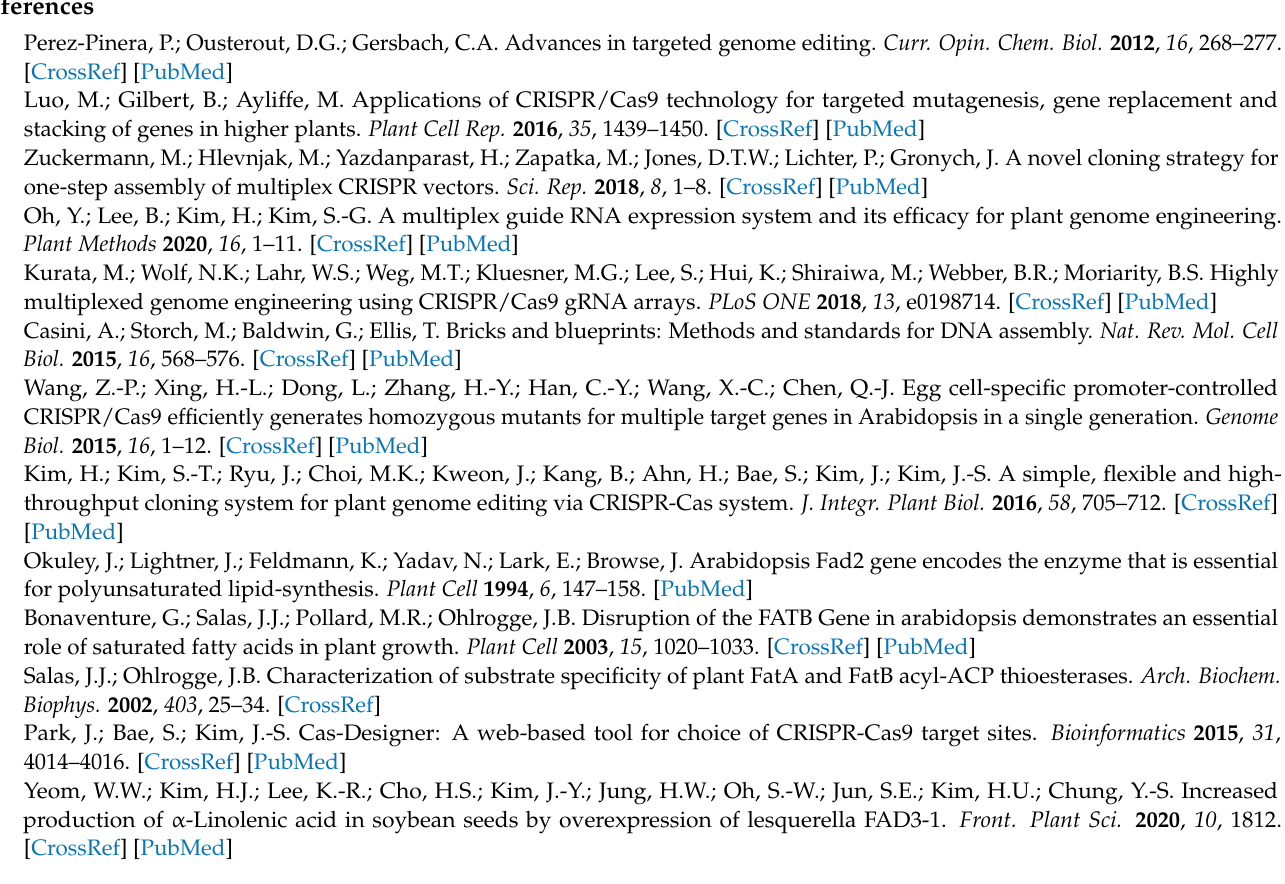
Table S1: Indel ratio of pHEE401E_4sg transgenic T0 generation soybean. Table S2: Indel ratio